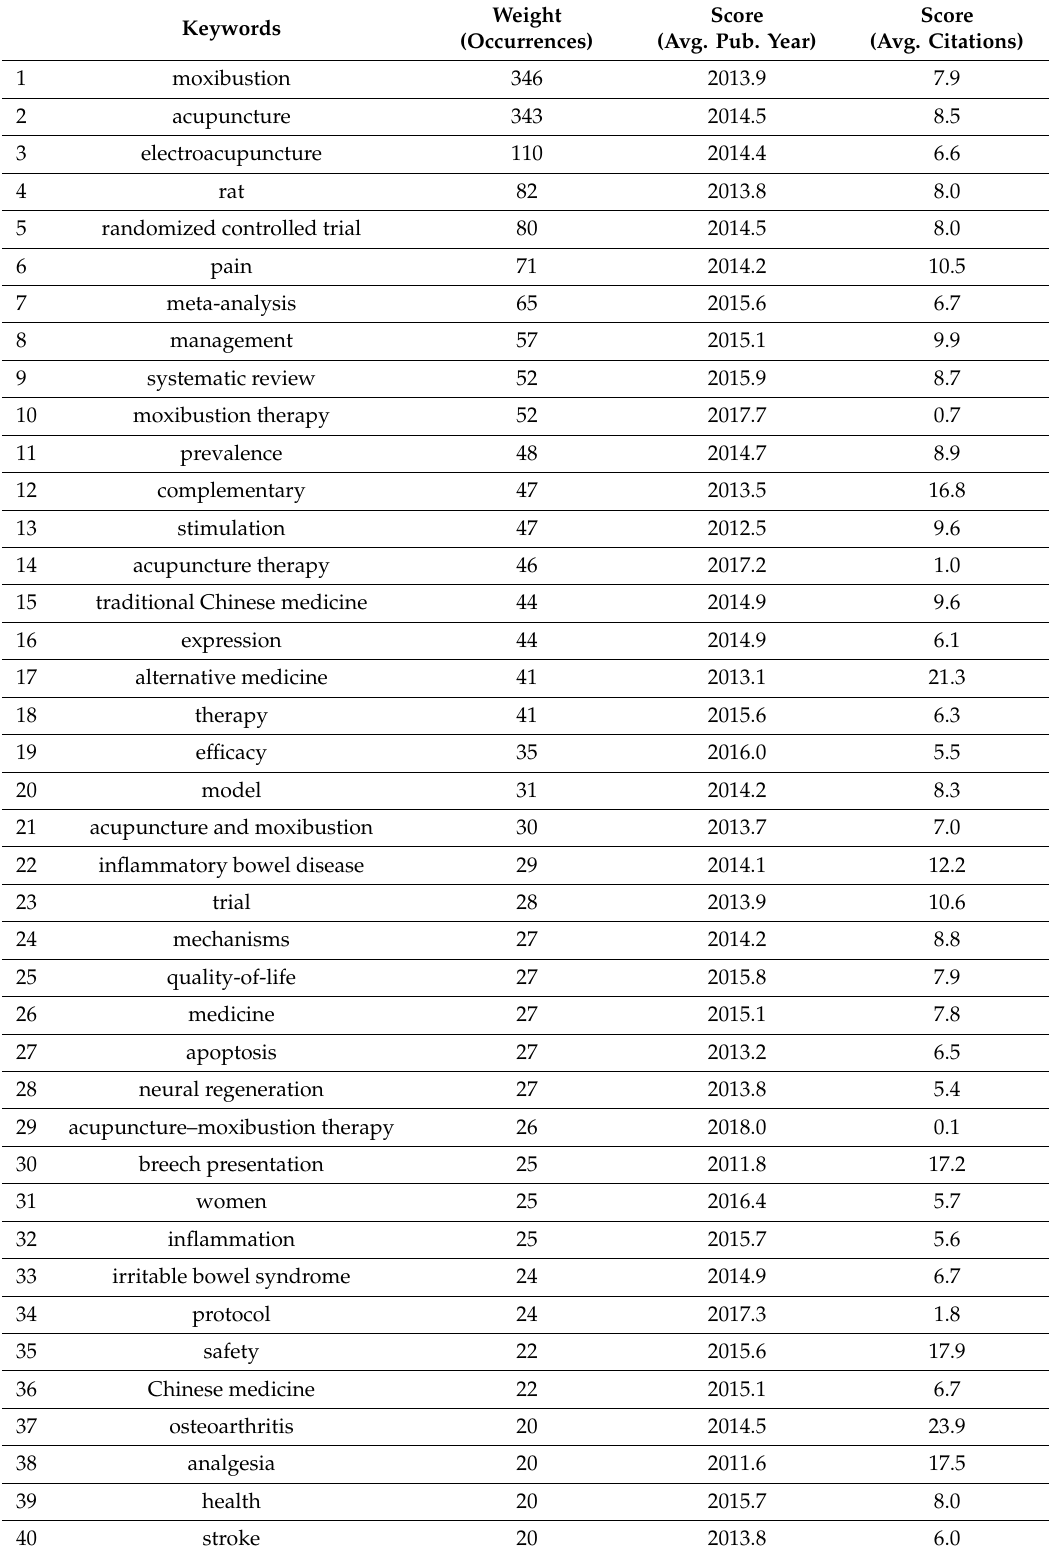
Table 3. Occurrences, average publication year, and average citations of 40 keywords that have occurred over 20 times in the title or abstract fields across all